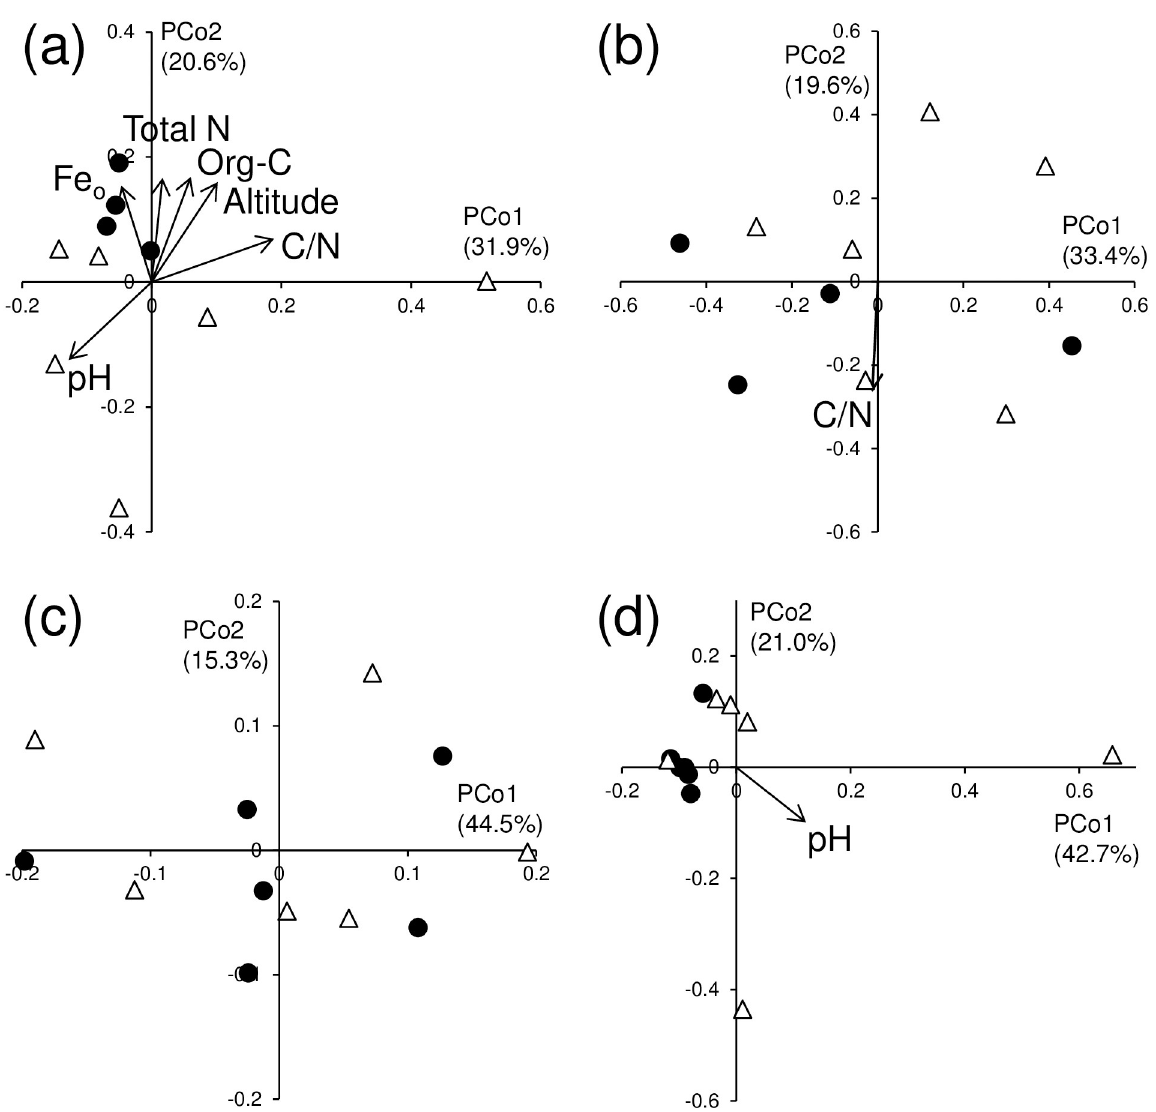
Fig 3. Principal coordinate analysis ordination of (a) bacterial DGGE profiles, (b) fungal DGGE profiles, (c) bacterial CLPP using the ECO plate, and (d) fungal CLPP using the SFN2 plate in the A horizon of Andosols and Cambisols. Filled circle: Andosols; hollow triangle: Cambisols. Vectors for the significantly correlated ( p < 0.1) environmental variables are superimposed on the